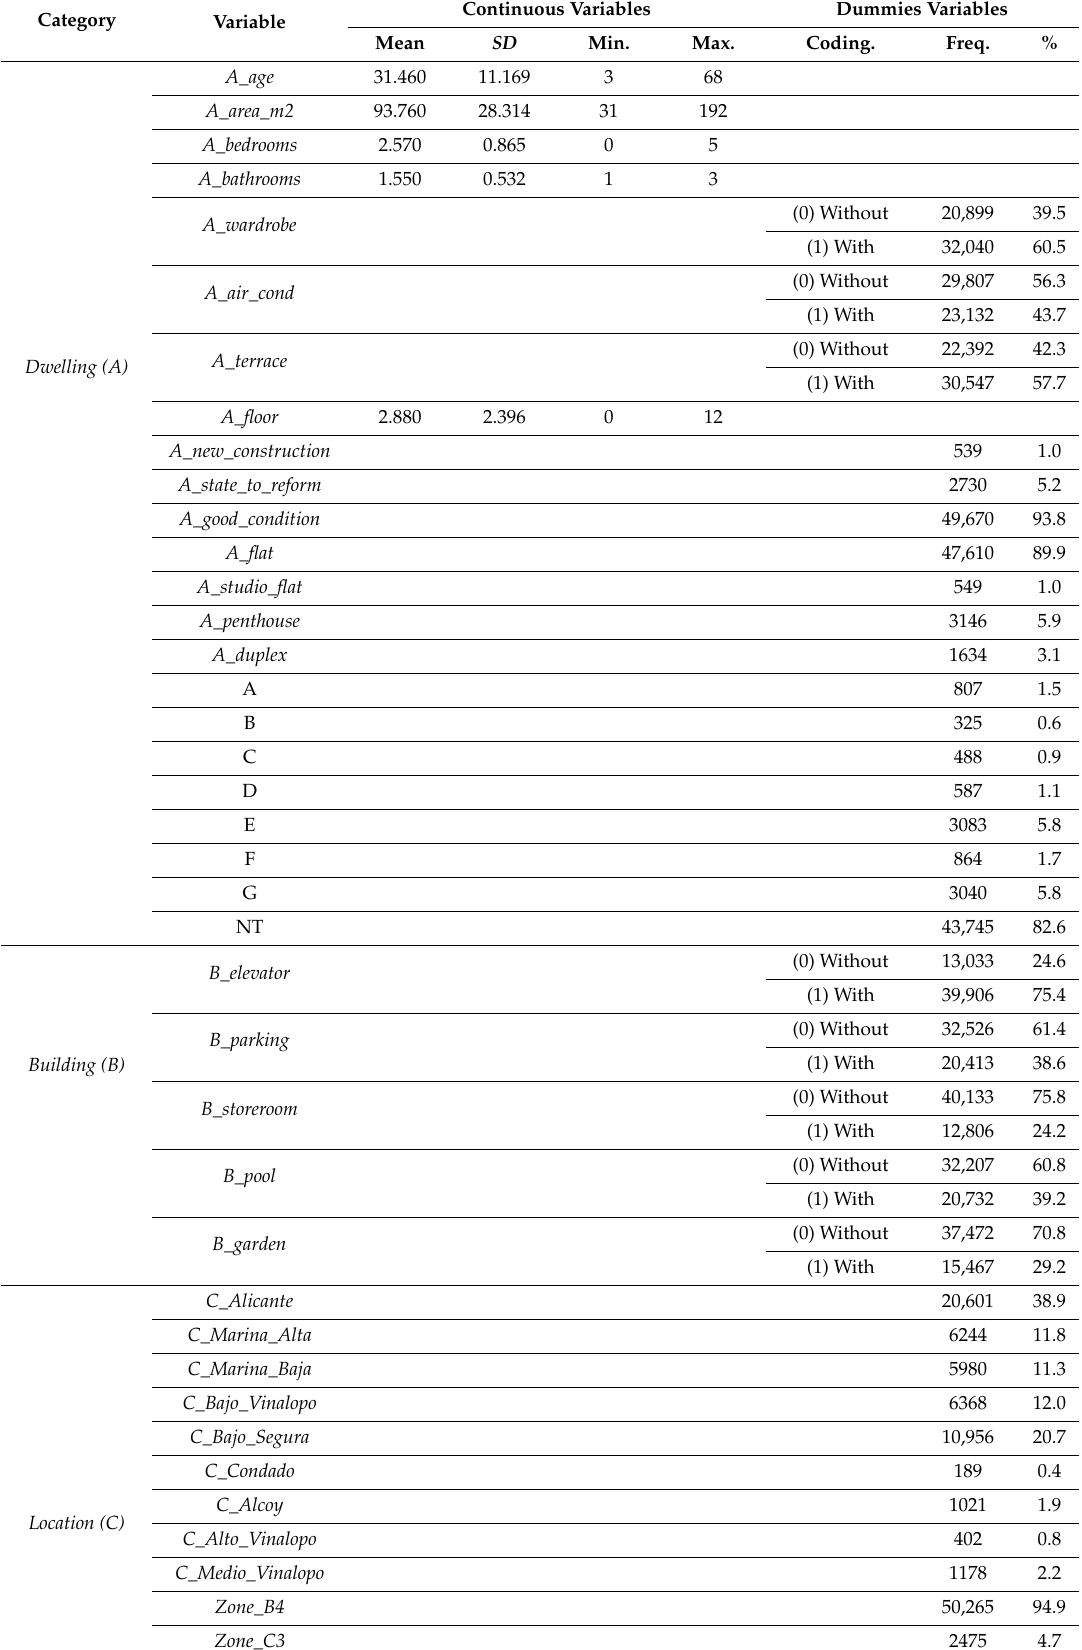
Table 2. Descriptive statistics for the